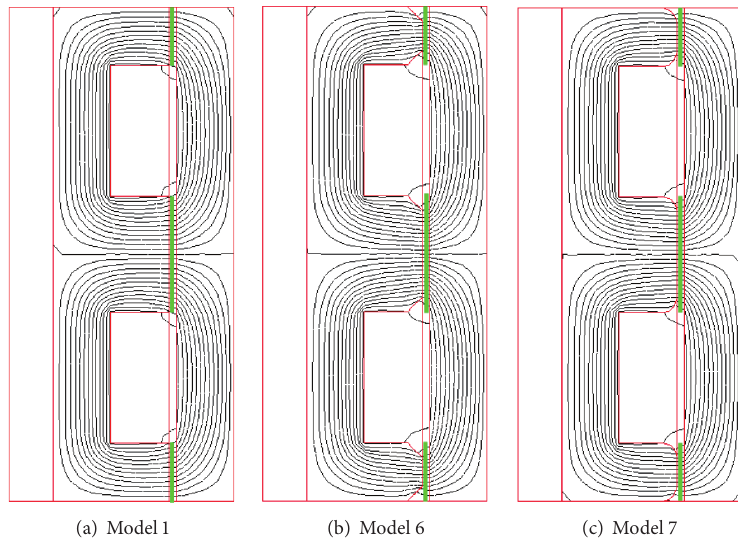
Figure 7: Distributions of magnetic flux lines of different models.